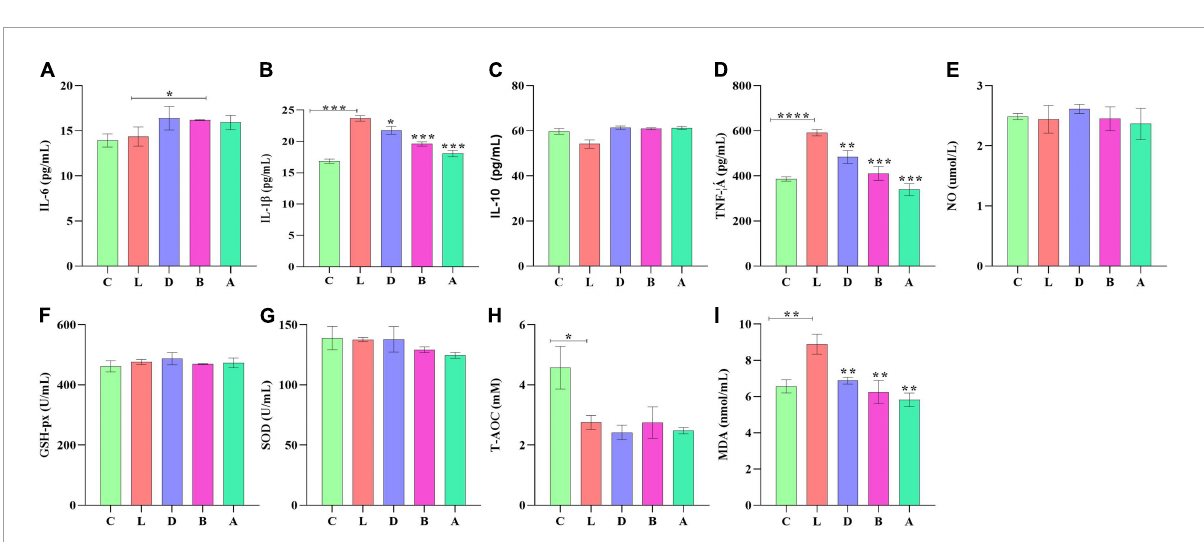
FIGURE3 Sodium acetate/sodium butyrate supplementation improved the inflammation response and oxidative stress of mouse induced by LPS. The concentrations of inflammatory cytokines IL-6 (A) , IL-1 β (B) , IL-10 (C) , TNF- α (D) , and NO (E) in serums. Oxidative status indices levels of GSH-px (F) , SOD (G) , T-AOC (H) , and MDA (I) in serums. Significance is presented as * p < 0.05, ** p < 0.01, *** p < 0.001, and **** p < 0.0001; data are presented as the mean ± SEM ( n = 3).